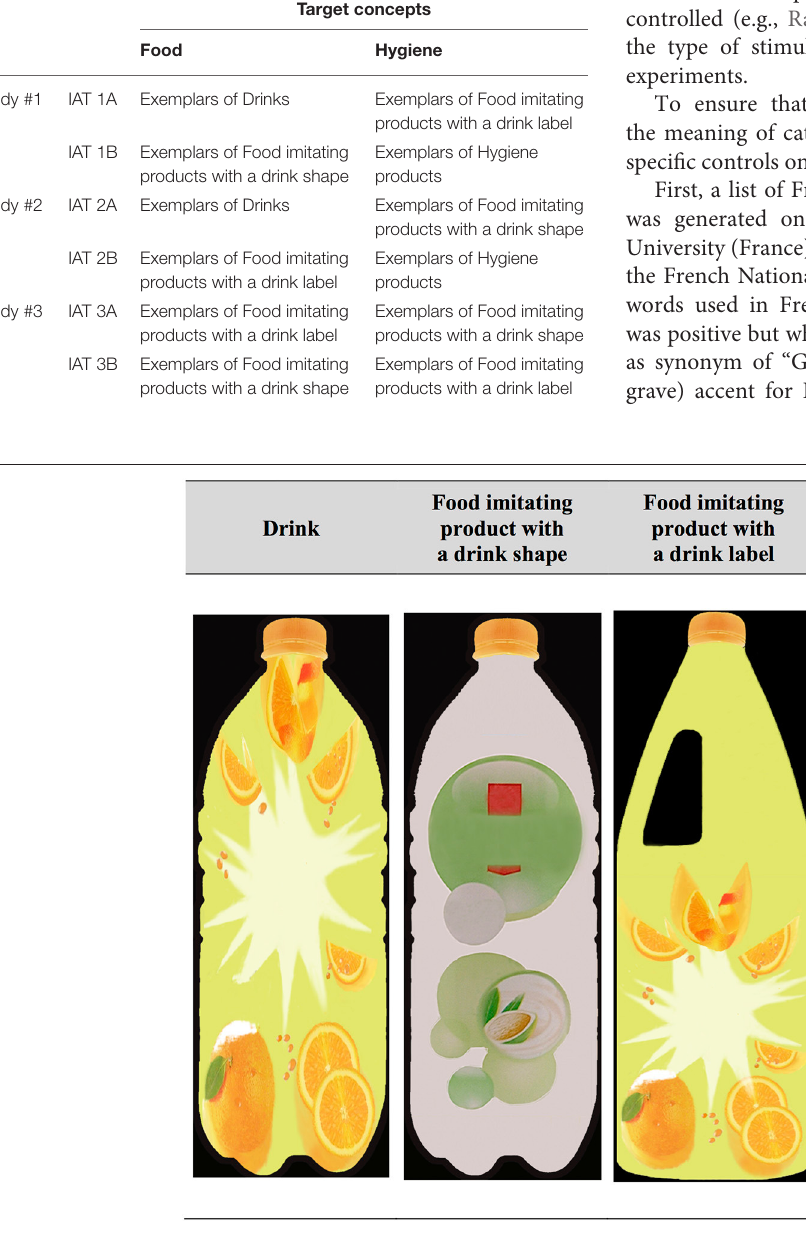
Frontiers in Psychology |